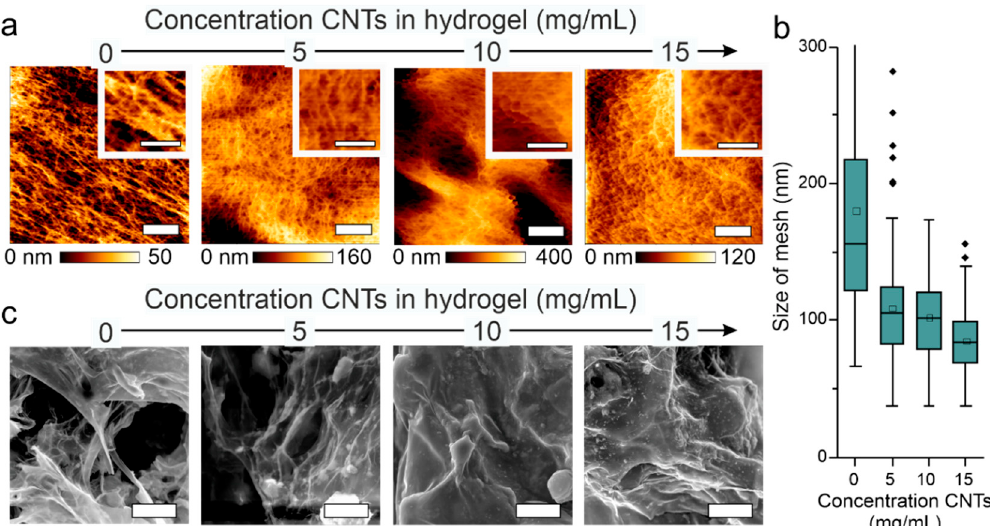
Figure 2. ( a ) Topography (height) mapping of the surface of GG-CNTs hydrogels obtained by atomic force microscopy (AFM). The scale bars are 1 μ m; scale bars in insertion are 0.5 μ m. ( b ) Size of the mesh of GG-CNTs hydrogels. ( c ) SEM images of the surface of GG-CNTs hydrogels. The scale bar is 50 μ m.